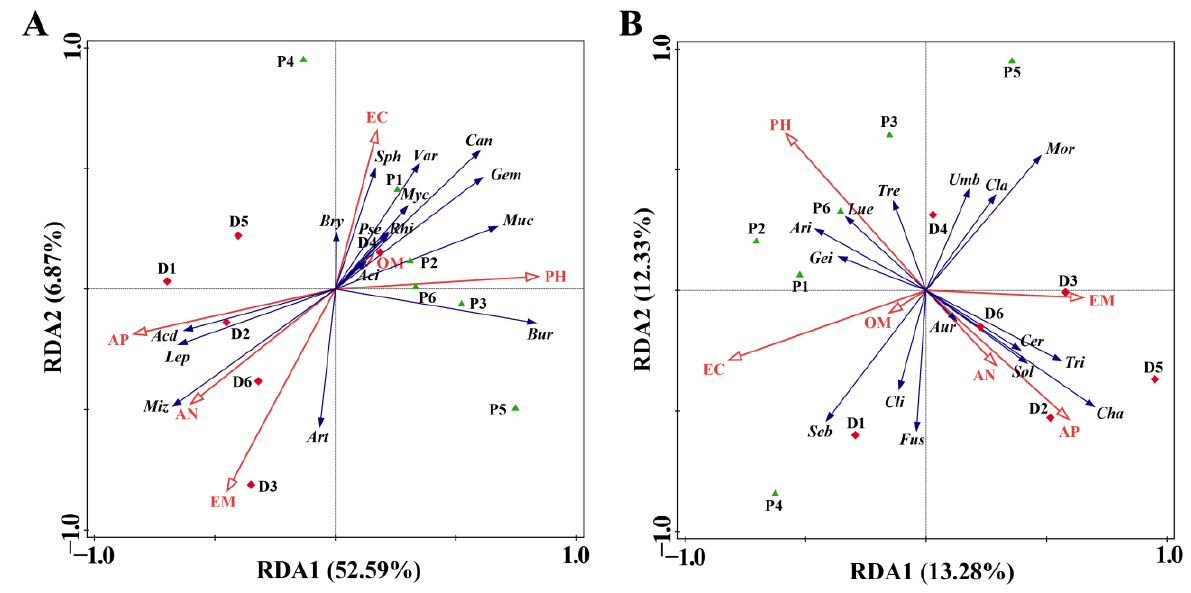
Figure 4. Redundancy discriminant analysis (RDA) of microbial community composition in rhizo- sphere soil at genus levels. ( A ) Bacteria; ( B ) Fungi. The red diamond and green up triangle icons represent samples from decline-diseased bayberry alone (D) and disease in combination with prochlo- raz (P). PH (pH); OM (organic matter); AN (alkali-hydrolyzable nitrogen); AP (available phosphorus); EC (exchangeable calcium); EM (exchangeable magnesium); Acd ( Acidibacter ); Aci ( Acidothermusl ); Ari ( Articulospora ); Art ( Arthrobacter ); Aur ( Auricularia ); Bry ( Bryobacter ); Bur ( Burkholderia ); Can ( Candidatus solibacter ); Cer ( Ceratobasidium ); Cha ( Chaetomium ); Cla ( Cladophialophora ); Cli ( Clitopilus ); Fus ( Fusarium ); Gem ( Gemmatimonas ); Gmi ( Geminibasidium ); Lep ( Leptospirillum ); Lue ( Luellia ); Miz ( Mizugakiibacter ); Mor ( Mortierella ); Muc ( Mucilaginibacter ); Myc ( Mycobacterium ); Pse ( Pseudomonas ); Rhi ( Rhizomicro- bium ); Seb ( Sebacina ); Sol ( Solicoccozyma ); Sph ( Sphingomonas ); Tre ( Trechispora ); Tri ( Trichoderma ); Umb ( Umbelopsis ); Var ( Variibacter ). Table 4. Contribution of soil properties to rhizosphere soil bacterial and fungal taxa at the genus